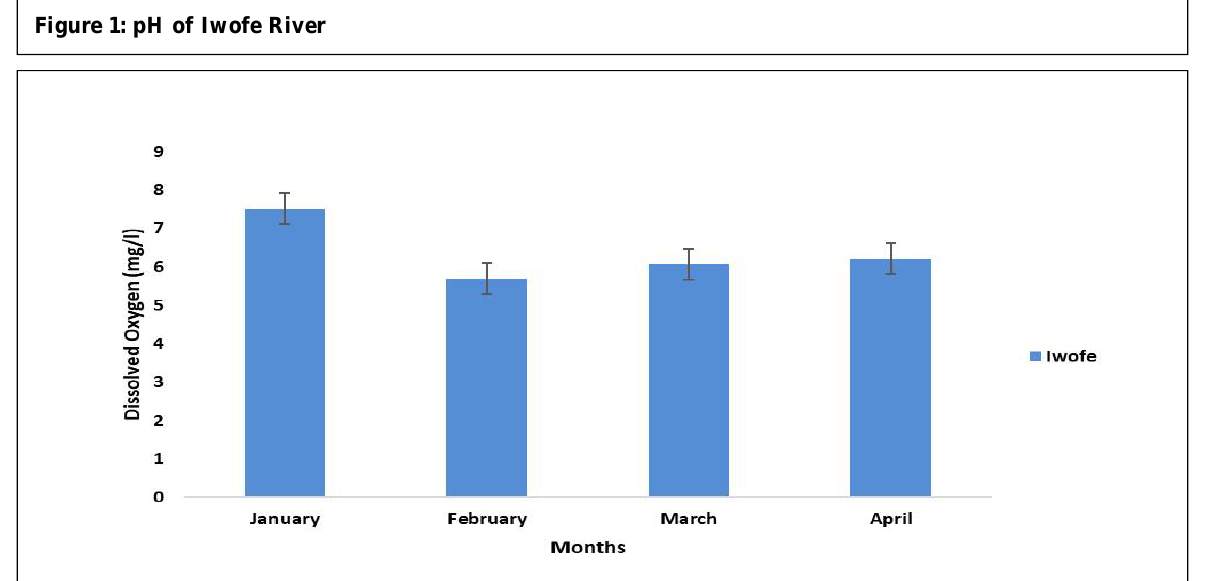
Figure 2: Dissolved Oxygen level of Iwofe River